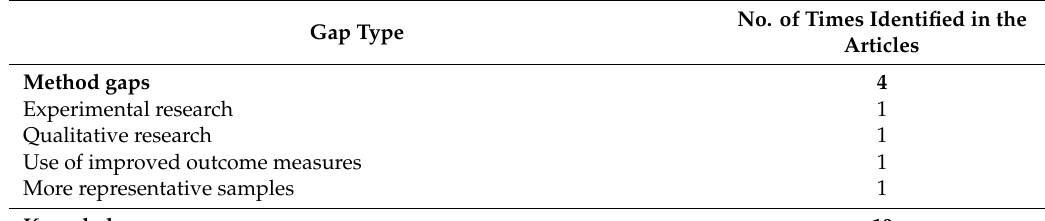
Table 6. Gambling advertising and inducements